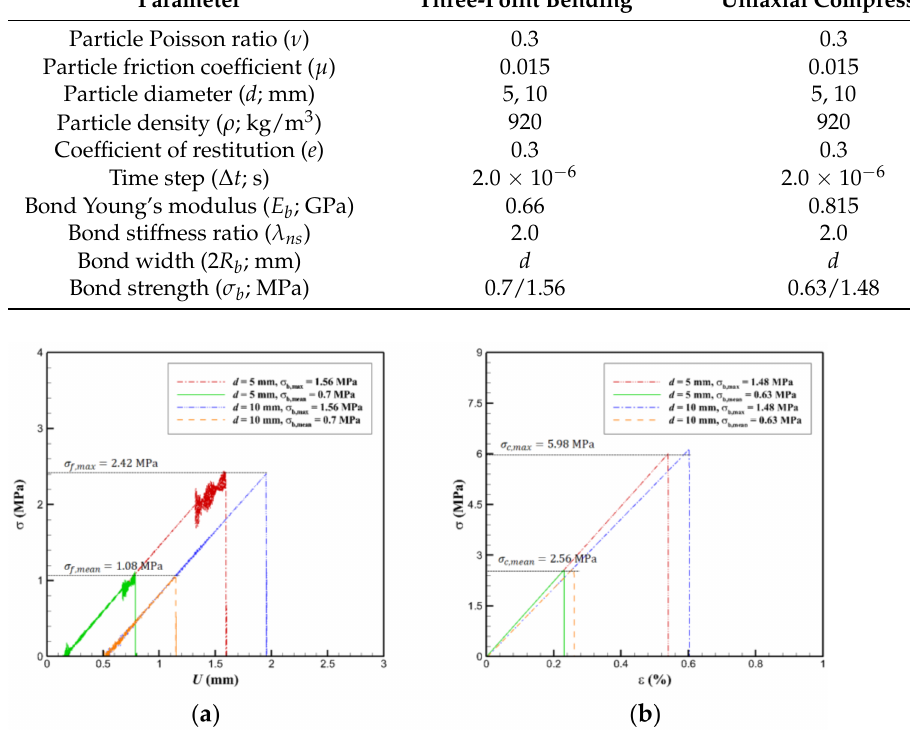
Figure 11. Stress–deformation curve for validation: ( a ) flexural strength; ( b ) compressive strength. Table 4. Flexural strength and compressive strength in the Bohai